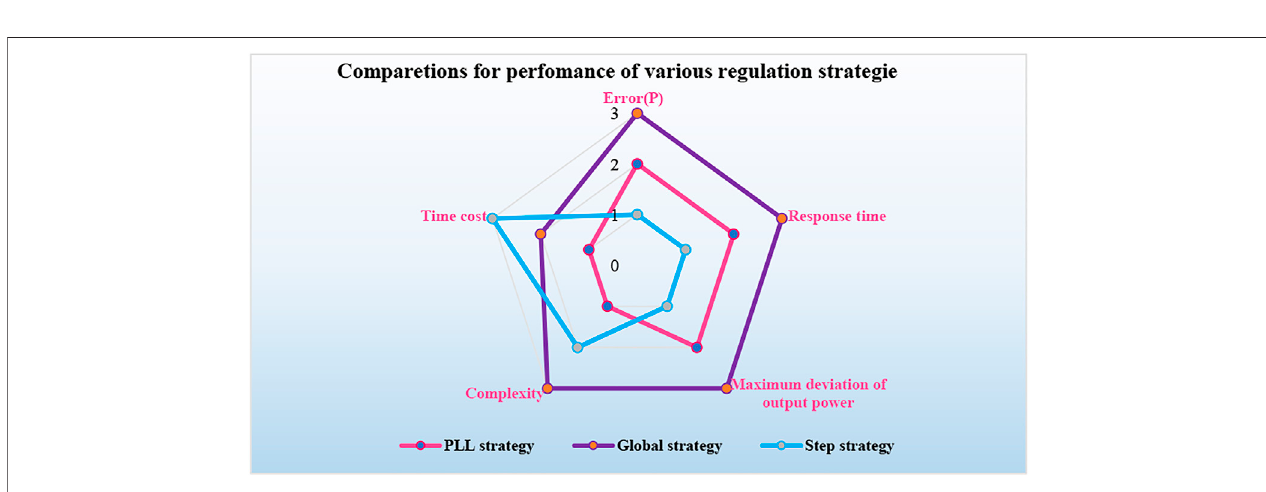
FIGURE 6 | Radar map of optimization performance under different regulation strategies.